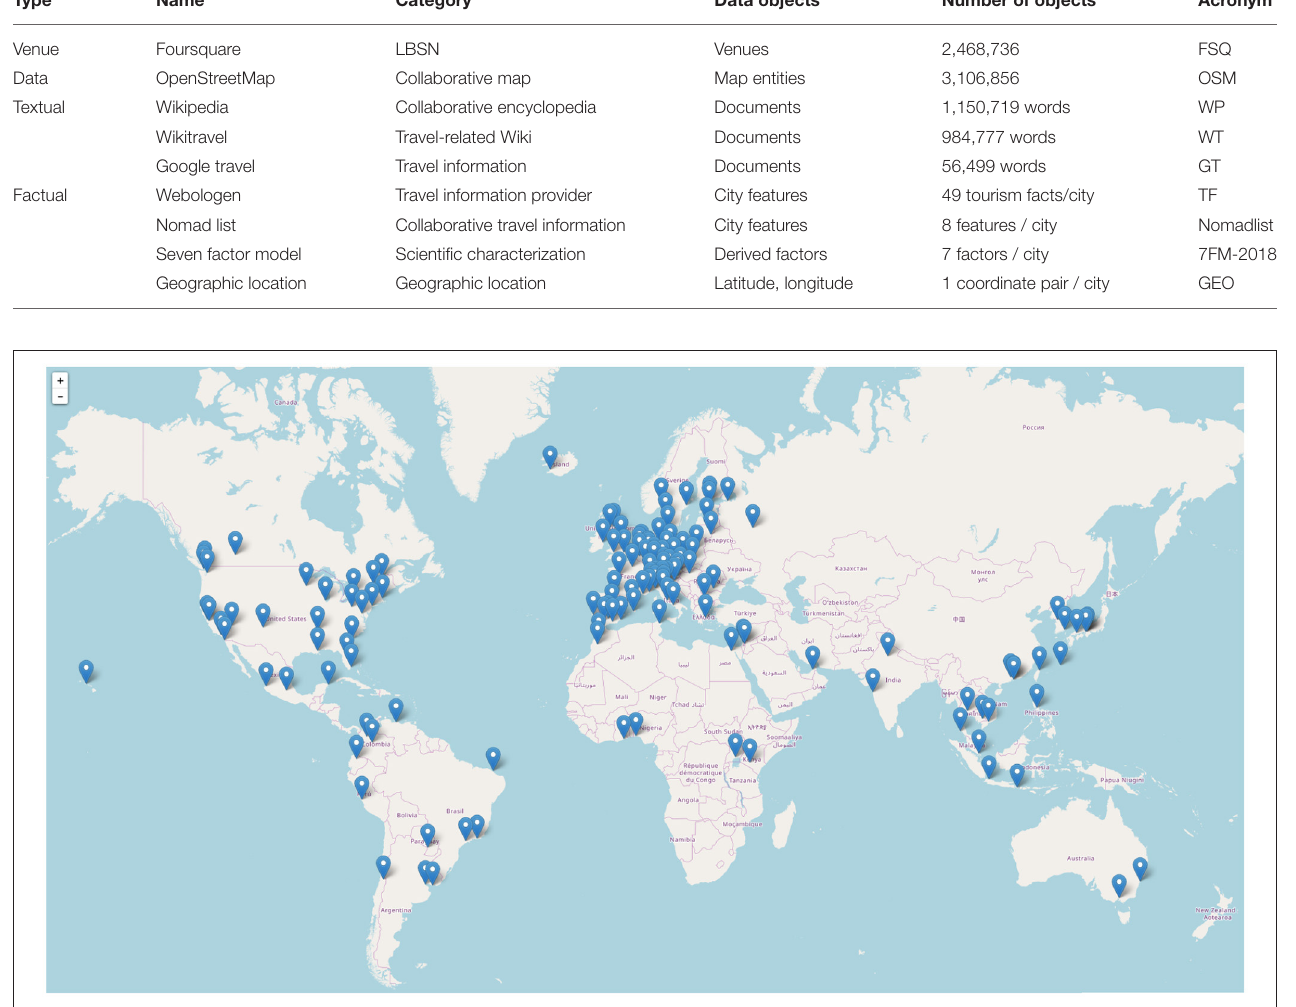
FIGURE 1 | Geographic distribution of the characterized cities. Map data © OpenStreetMap contributors, see